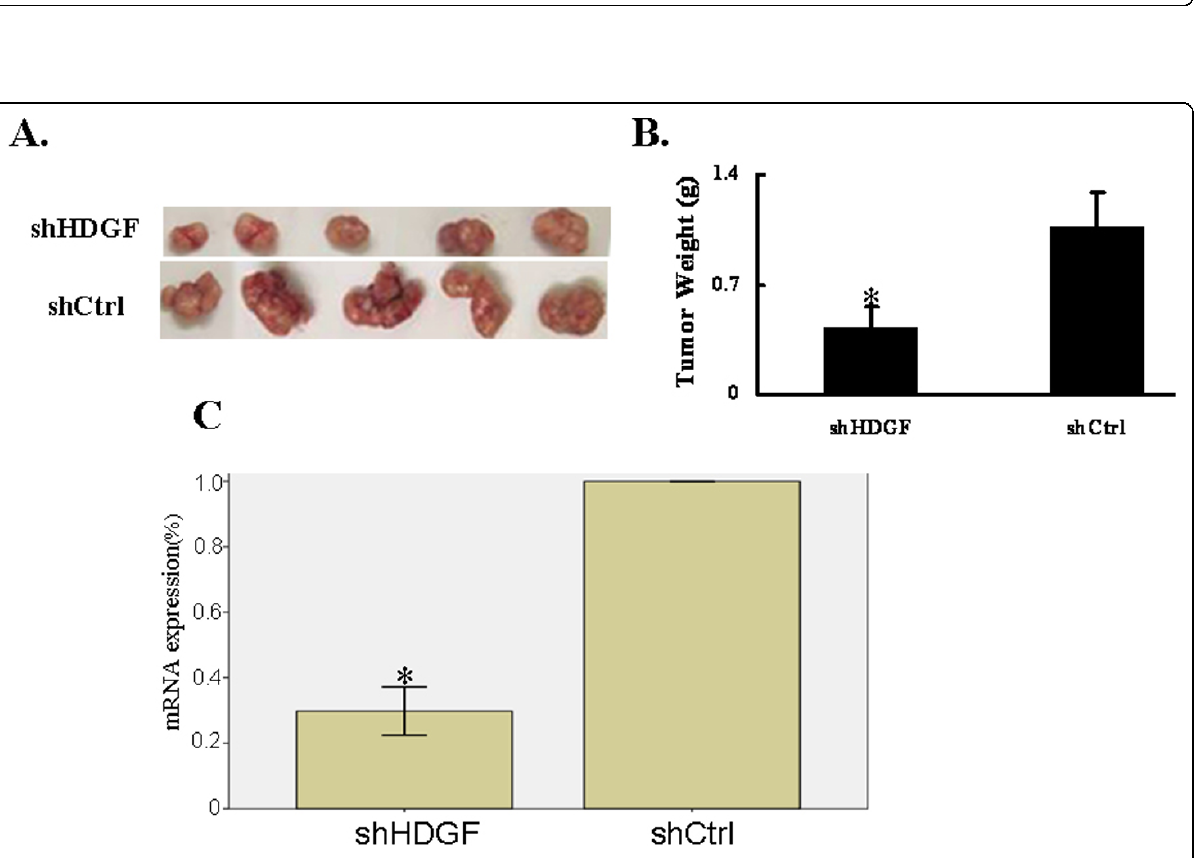
Figure 5 Down-regulation of HDGF reduced cell migration and invasion . The migrating (A and B) and invading (C and D) capabilities of parental HepG2 cells and their stable derivatives, shCtrl and shHDGF, were examined by transwell and boyden chamber assay. A and C . Migrated or invaded cells were photographed under the microscope (200×). B and D . Quantifications of migration and invasion were presented as mean ± SD for three independent experiments. * P < 0.05, as compared to parental HepG2 cells and shCtrl cells.